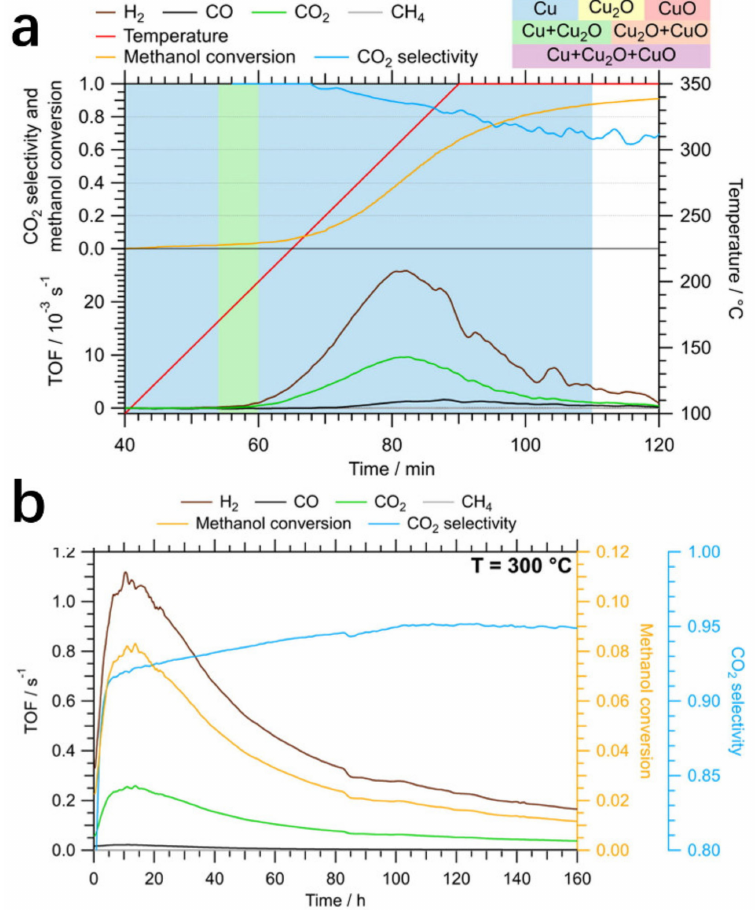
Figure 6. Methanol steam reforming catalyzed by Cu/ZrO 2 catalyst: ( a ) Methanol steam reforming curves of m-ZrO 2 supported catalysts between 100 ◦ C and 350 ◦ C. ( b ) methanol steam reforming curves of catalysts at long time. Reproduced with permission [109]. Copyright Elsevier,